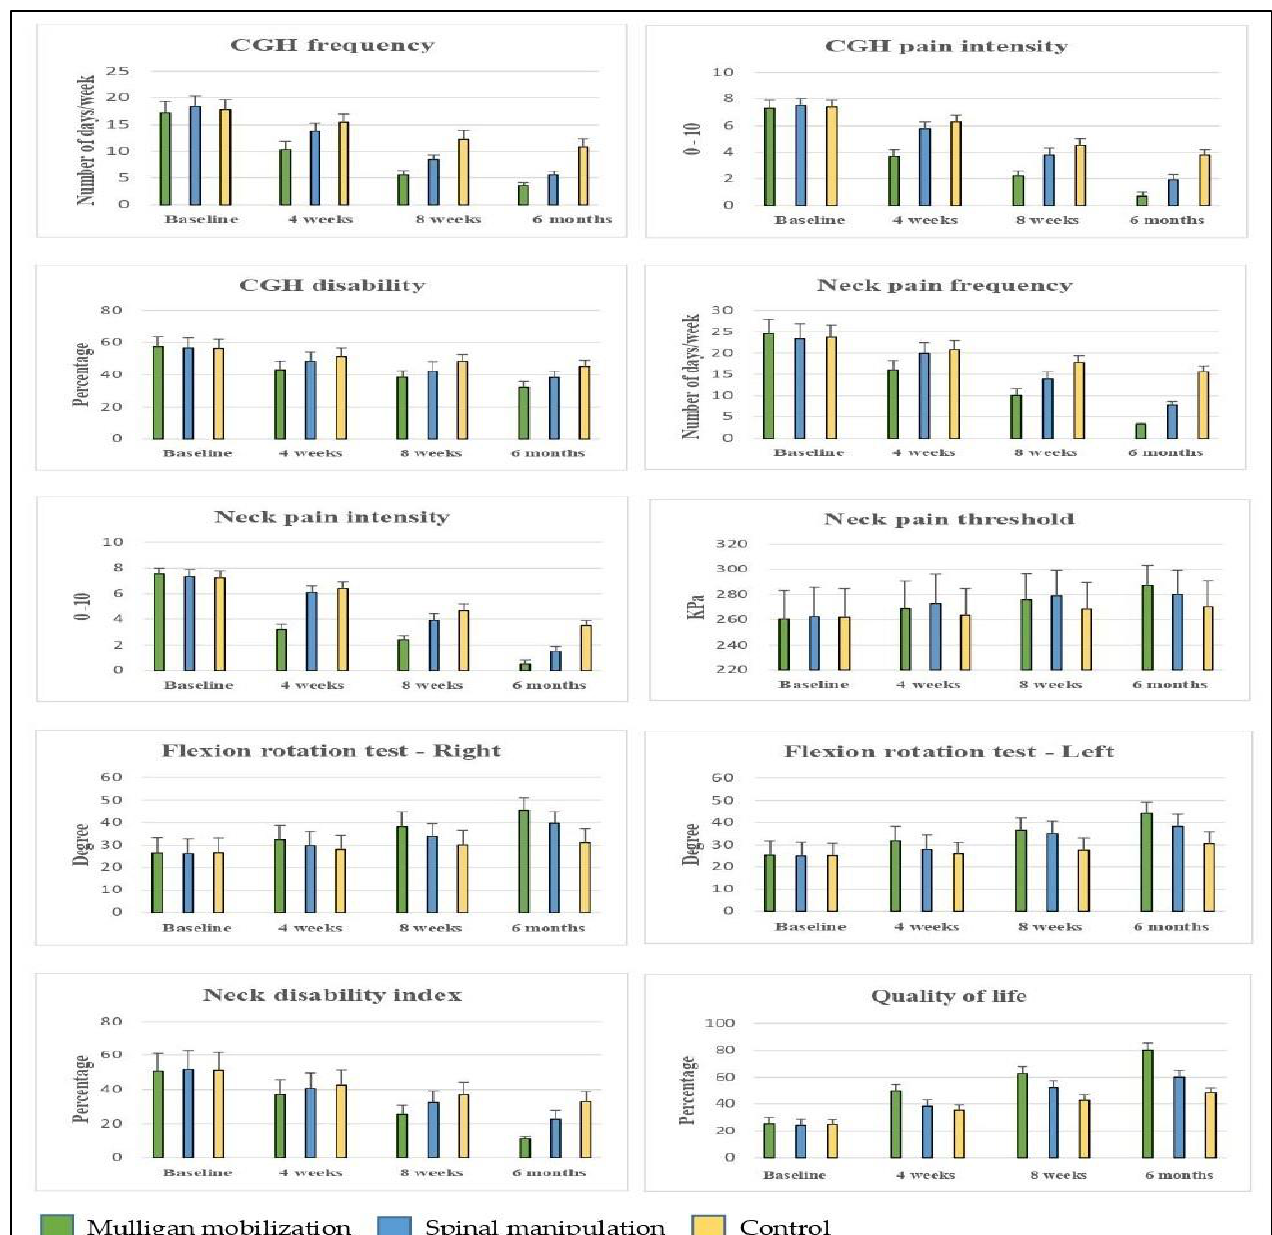
Figure 2. Pre- and post - primary and secondary outcome measure scores of MMT, SMT, and control